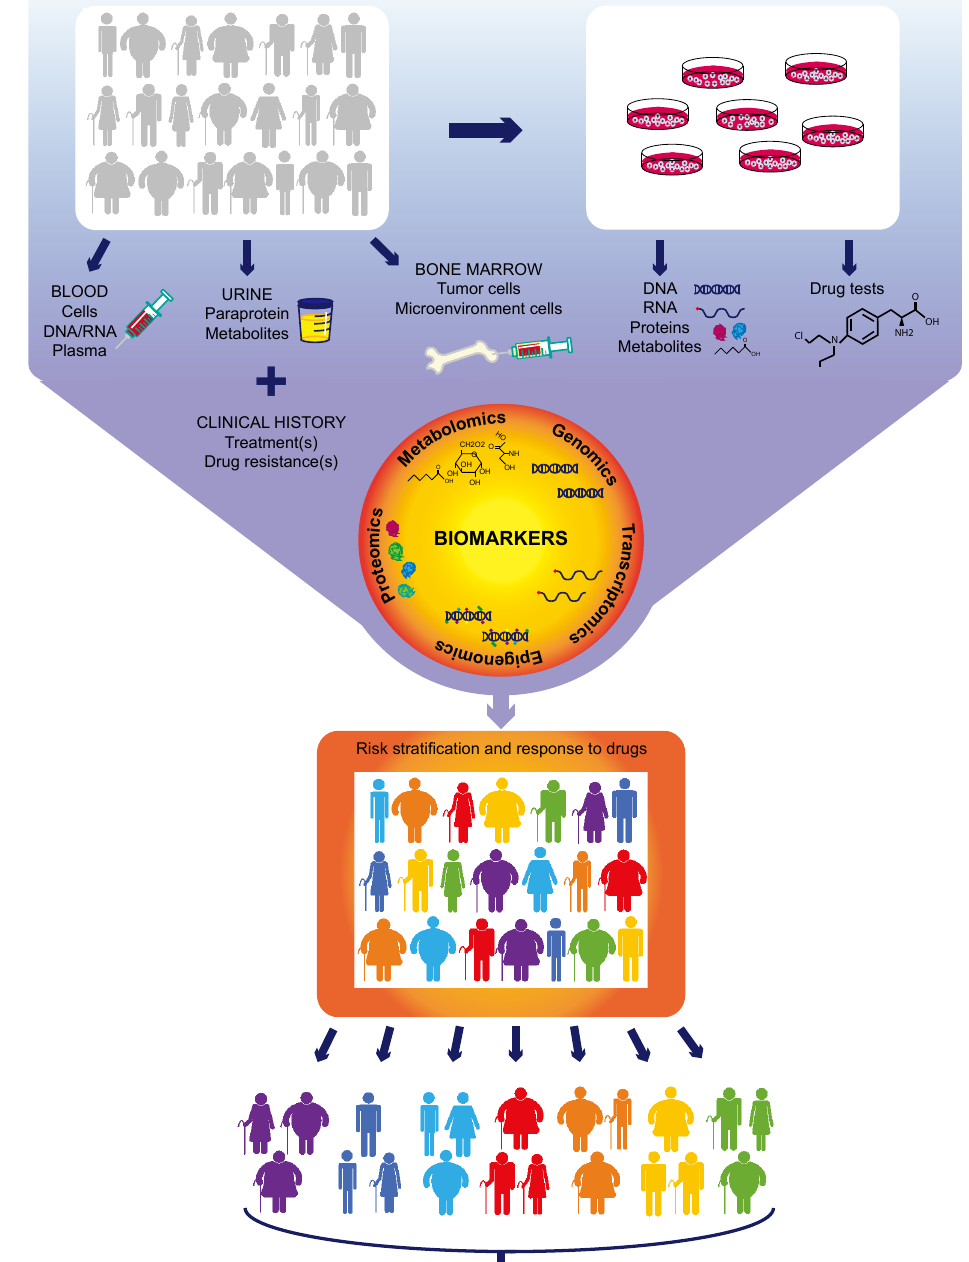
Explor Target Antitumor Ther. 2021;2:65-106 | https://doi.org/10.37349/etat.2021.00034